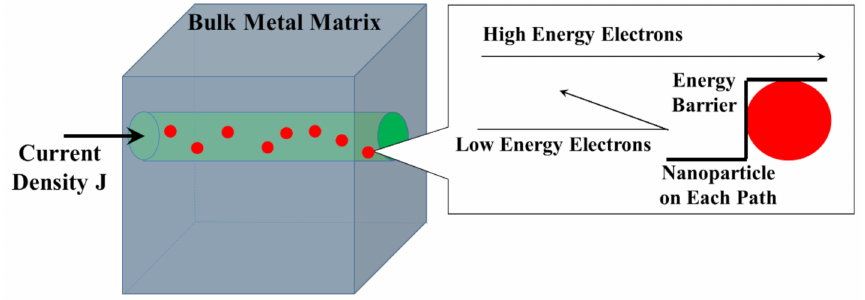
Figure 3. The schematic illustration of the scattering mechanisms in the Al–TiB 2 nanocomposite system (the left side indicates the structural impedance caused by nanoparticle incorporation, whereas the right side demonstrates the interfacial energy barrier formed by Al and TiB 2